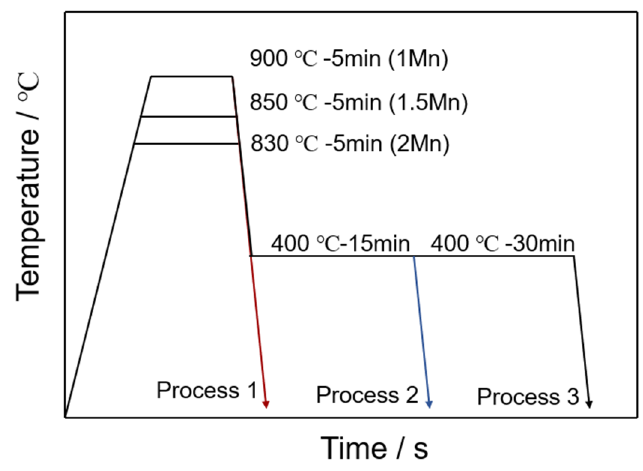
Figure 1. Schematic representation of the δ -TRIP steels heat treatment.